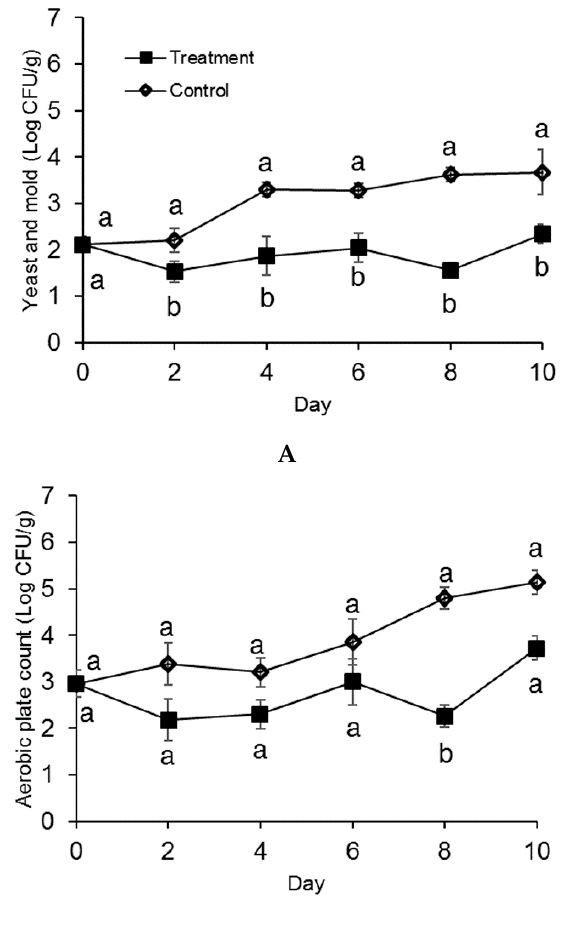
Figure 1. Yeast and mold count ( A ) and total aerobic plate count ( B ) of strawberries stored at 3 °C for 10 days in molded fiber baskets containing pullulan packaging films loaded with 1% w / w cinnamaldehyde SLN (treatment) or without (control). Different letters (a, b) for each day denotes a significant difference ( p < 0.05) between the treatment and the control. The error bars represent standard error.